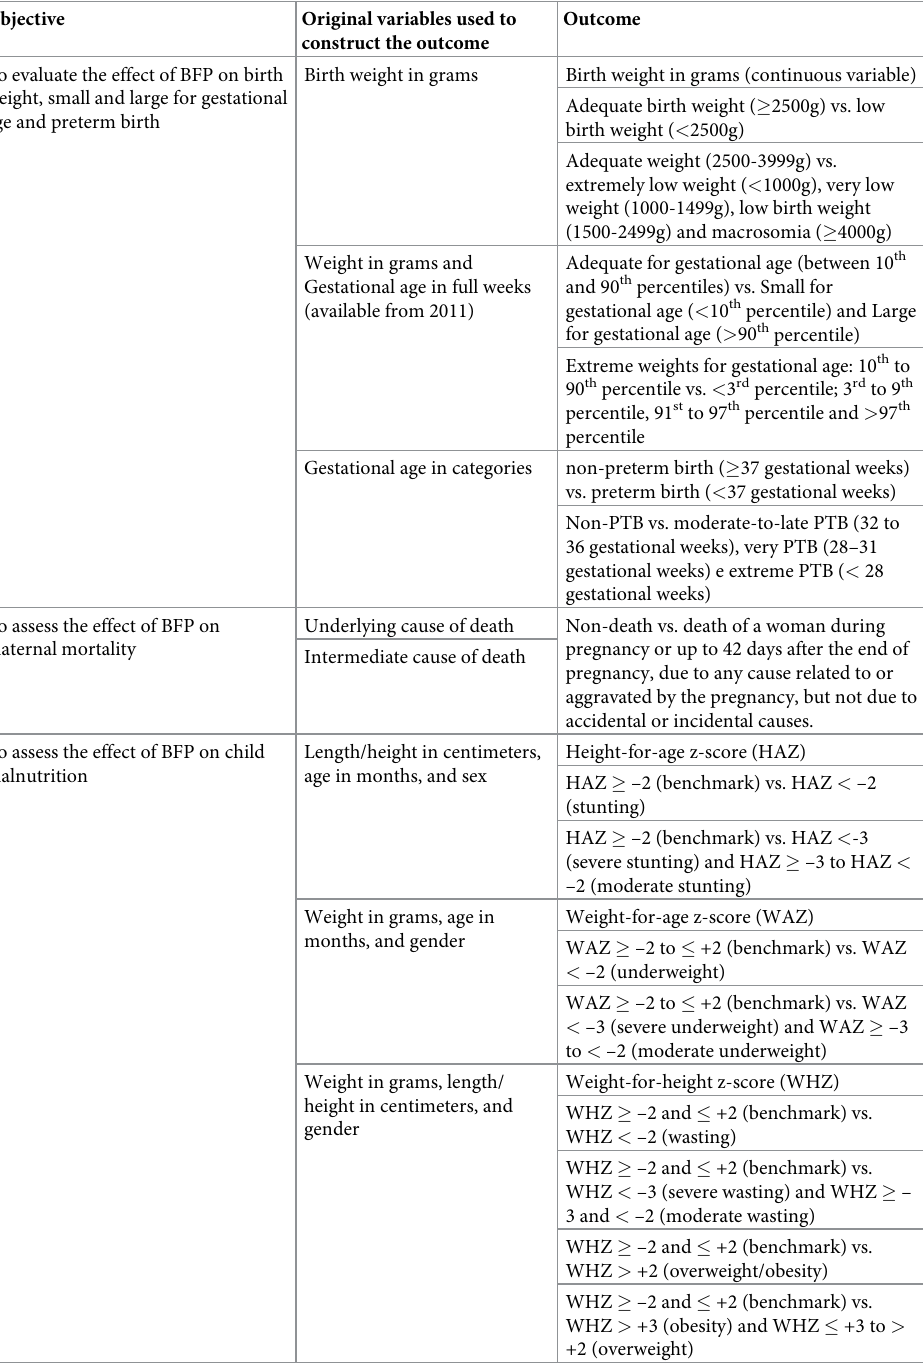
Table 3. Description of the outcomes that will be considered in studies by assessing the impact of the Bolsa Familia Program (BFP).